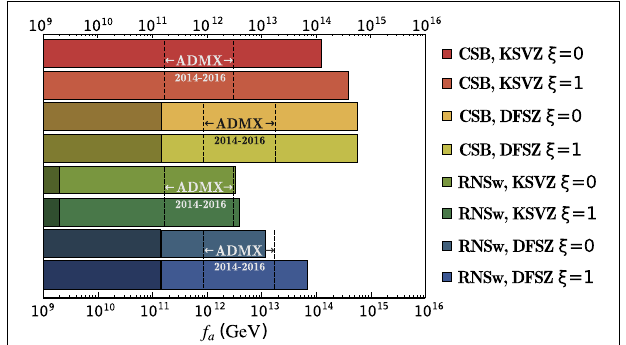
FIGURE 12 | Plot of thermally-produced neutralino abundance (cid:127) vs. M 2 along the RNSw model line.